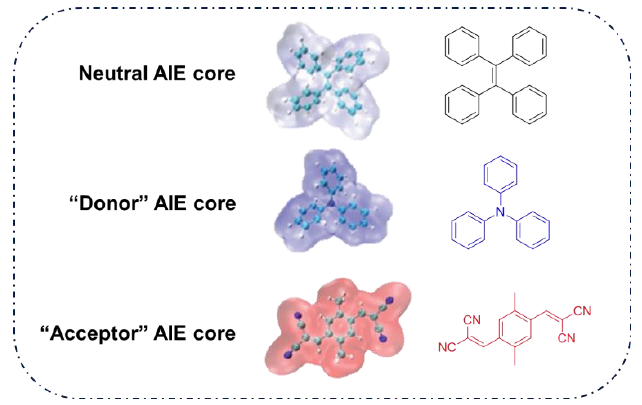
Figure 5. Classification of neutral, donor and acceptor AIE cores by their electron characters, the electronic clouds are represented by colored clouds (the neutral, donor and acceptor AIE cores are represented by the black, blue and red scheme, respectively). Table 1. Chemical structures, absorption/emission peaks, Δ E ST , consuming rate of ABDA, treatment efficiency and singlet oxygen quantum yield of different AIE – PSs (the donor and acceptor groups of different AIE – PSs are represented by the blue and red scheme, respectively).